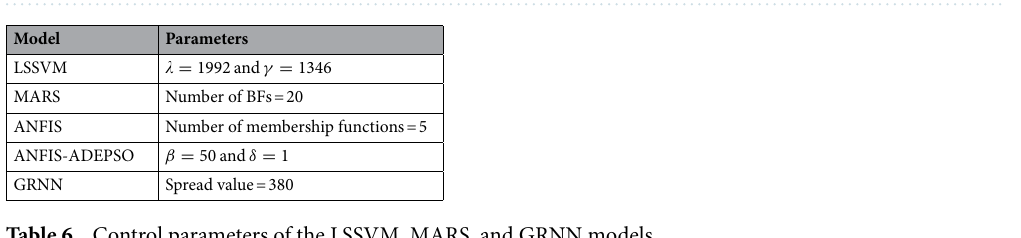
Table 6. Control parameters of the LSSVM, MARS, and GRNN